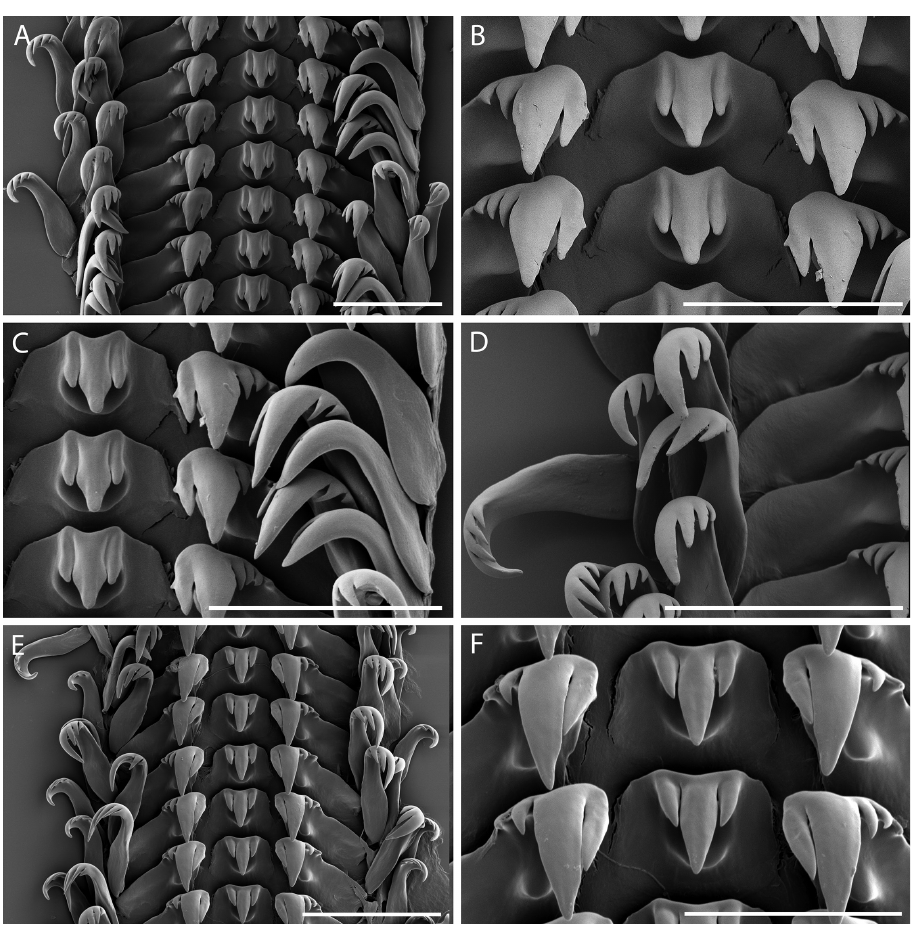
Figure 4. Radula morphology of Limatium aureum sp. n. A–D Holotype, MNHN IM-2013-42460, Austral Islands, Maria E, F Austral Islands, Pointe Kauira, RAPA 2002 stn. 36 A Radular ribbon B De- tail of rachidian and lateral teeth C Detail of half row, showing outer edges of lateral and marginal teeth D Detail of marginal teeth, showing inner edges E Radular ribbon of second specimen, showing variation in length of cusps F Detail of rachidian and lateral teeth, showing variation in width of rachidian and in length of cusps. Scale bar: 50 µm ( A, C, D, E ); 40 µm ( B ); 30 µm ( F Limatium sp. Fig. 3I, J, M Material examined. PHILIPPINES : MUSORSTOM 3 Stn. DR117, W of Mind- oro, 12°31'N, 120°39'E, 92–97 m, 1 lv (MNHN IM-2014-6930, Fig. 3I). VANUA- TU : SANTO 2006 stn. DS103, W of Tutuba I., Vunatavoa Bay, 15°34.1'S, 167°16'E, 10–80 m, 2 dd (MNHN IM-2014-6931, IM-2014-6932, Fig. 3J, M). Remarks. Three specimens (Fig. 3I, J, M) show an overall resemblance to L. aure- um , but differ in a manner that we think they are not conspecific. The three specimens